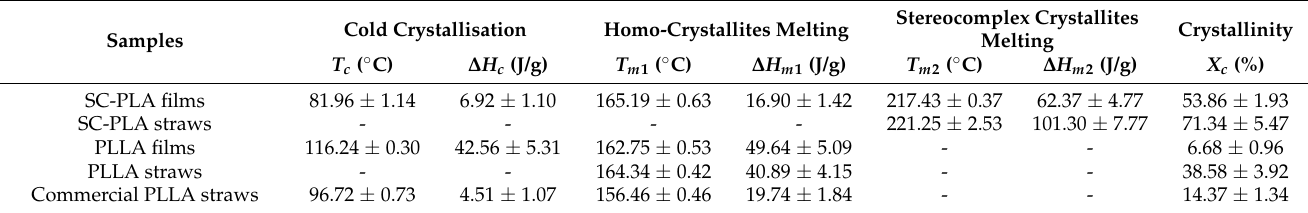
Stereocomplex Crystallites Melting